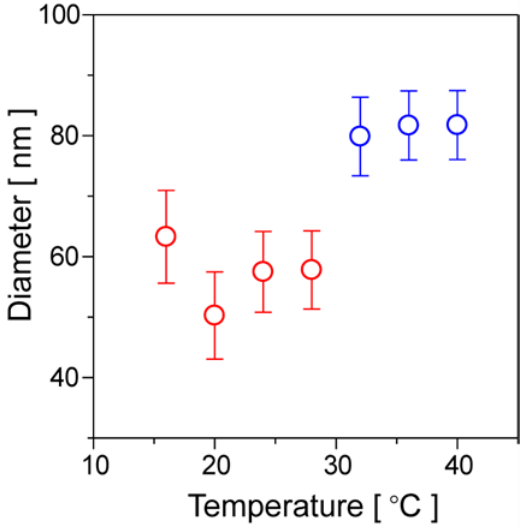
Figure 7. Dynamic light scattering (DLS)-based average particle sizes of nanomicelles and nanoparticles formed by two-step phase transitions of poly(NIPAAm- block -NIPAAm- co -PBA). The polymer concentrations were 2.0 mg · mL − 1 and 20 µ g · mL − 1 for measurement at 16–28 ◦ C and 32–40 ◦ C, respectively.